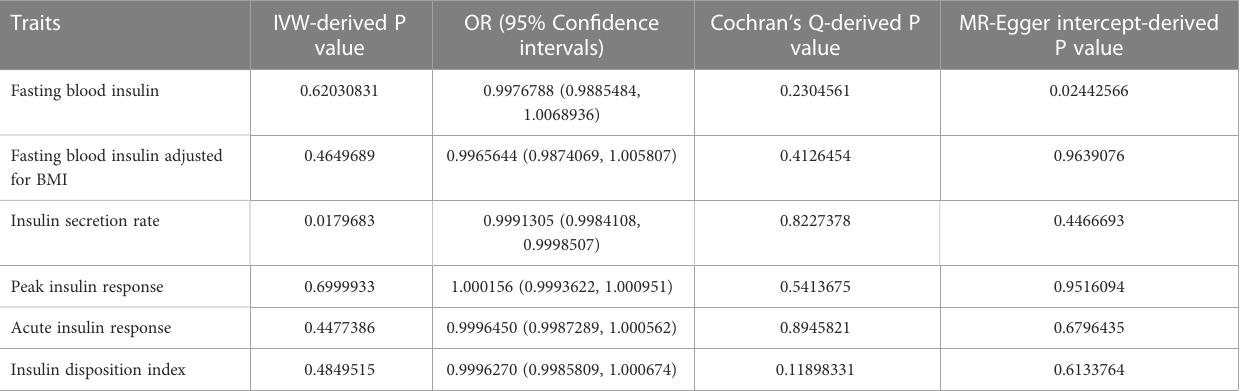
TABLE 2 Description of MR result.